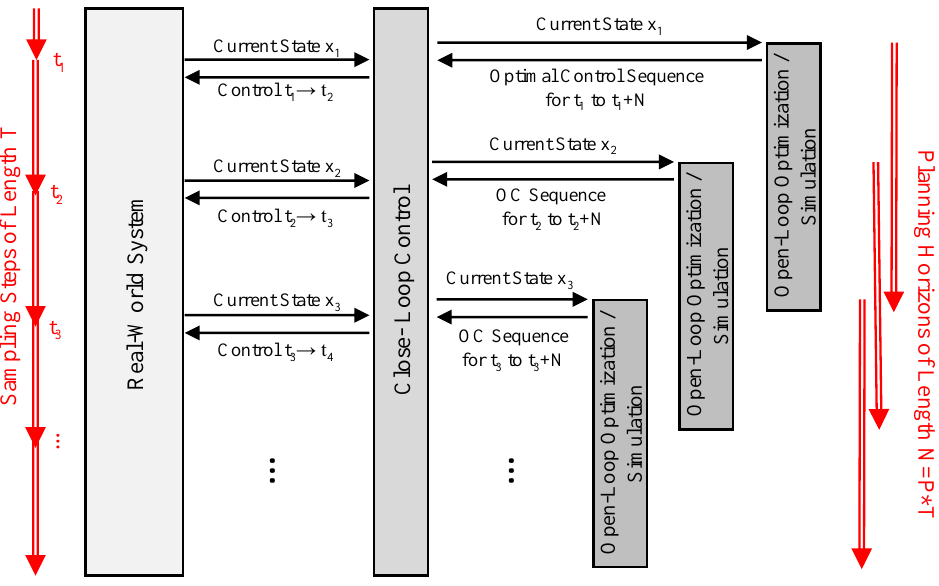
Figure 2. Schematic depiction of the Model Predictive Control scheme (following